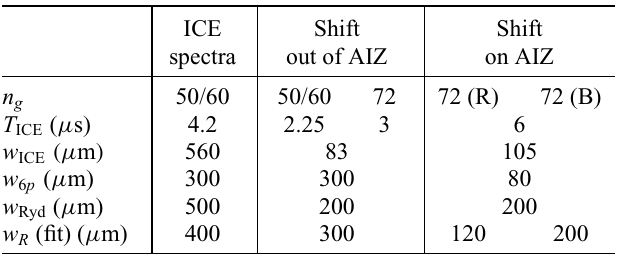
TABLE I. Typical values for relevant experimental parameters over the different measurements. “(R)” and “(B)” denote, respec- tively, the red- or blue-detuned AIZs. For w R , we display typical values obtained after data analysis.